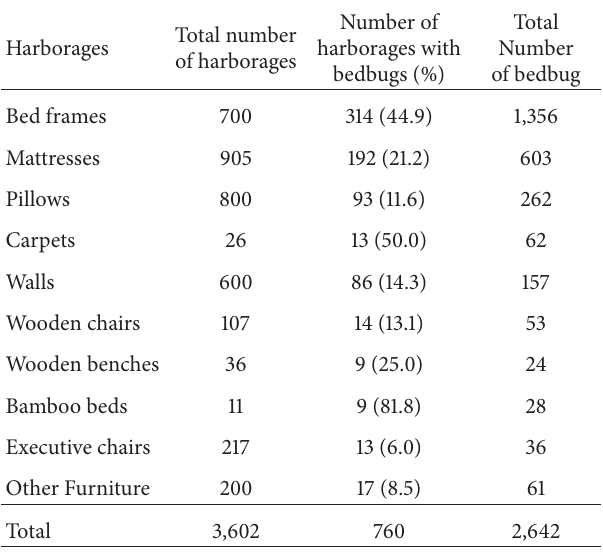
Table 3: Distribution of bedbugs in different harborages in homes and hostels in